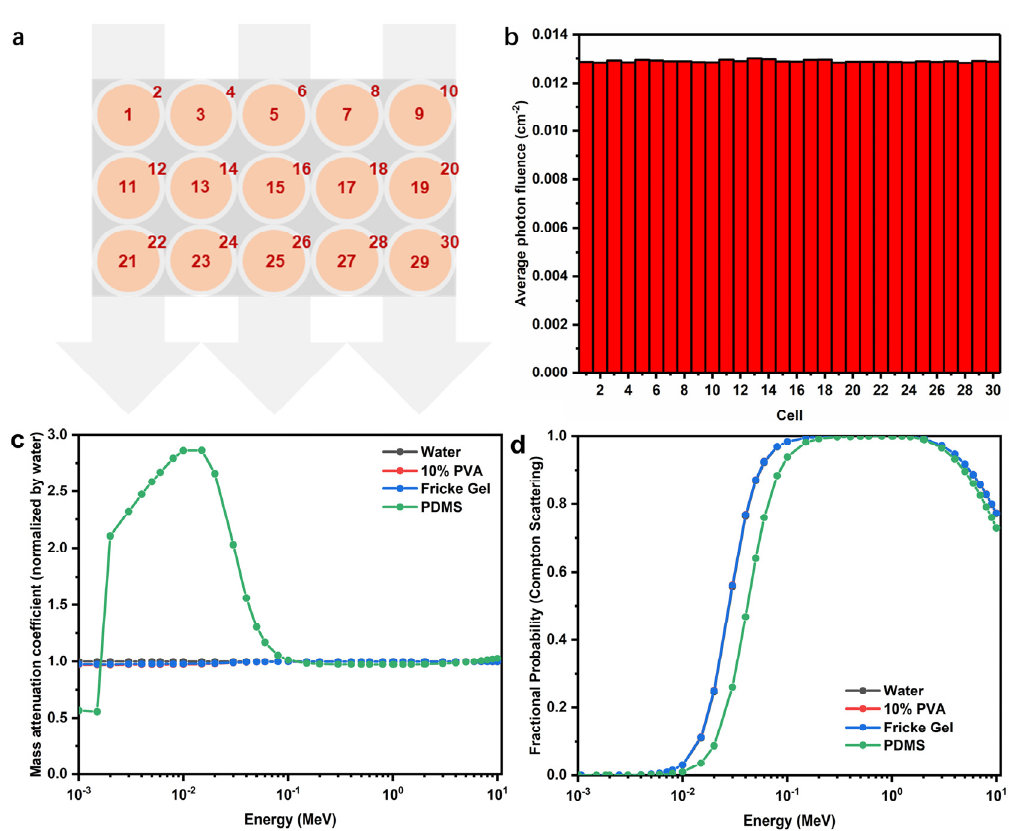
Figure 10. ( a ) Modeling diagram of FPX@PDMS dosimeter. ( b ) Average photon fluence (normalized to per source particle) in different cells. ( c ) Normalized mass attenuation coefficient as a function of photon energy in different materials. ( d ) Fractional probability of Compton scattering as a function of photon energy in different materials.